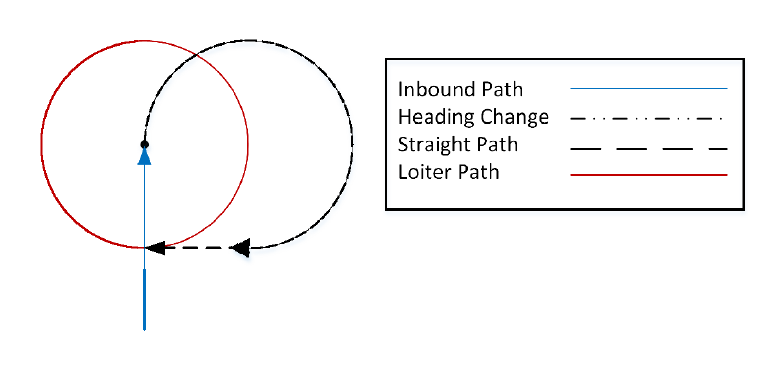
Figure 5. Fly through loiter path